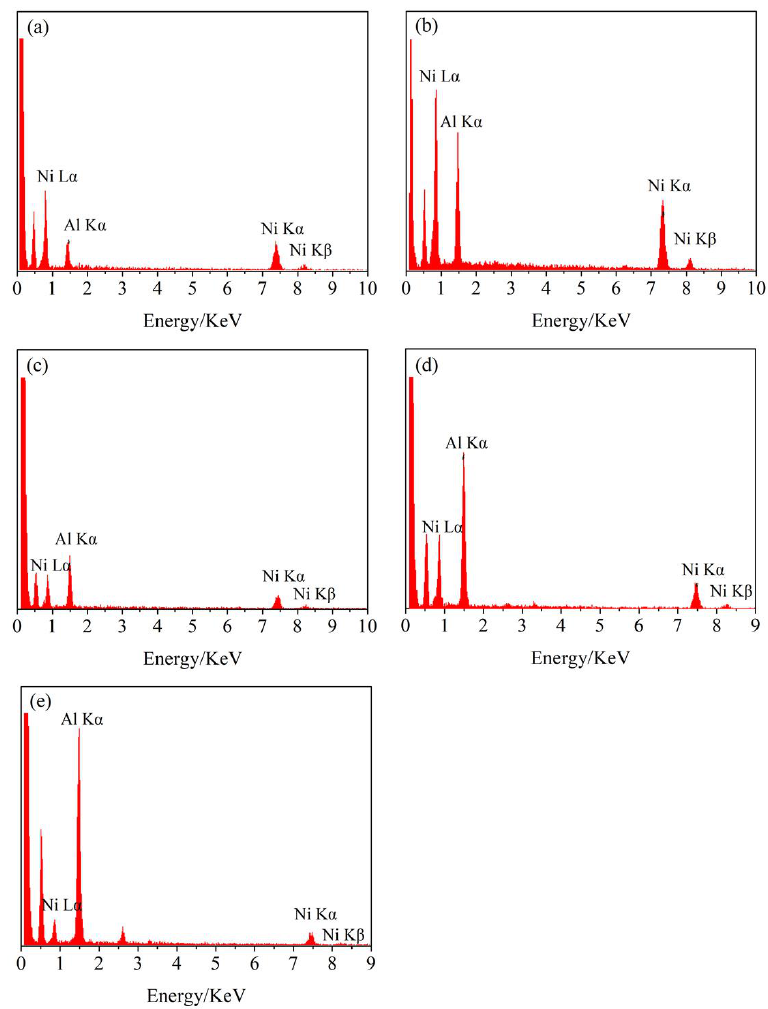
Figure 6. EDS of samples obtained by potentiostatic electrolysis on Ni plate at different potentials from LiCl-KCl-AlCl 3 (2 wt.%) melts at 753 K, ( a ) − 1.0 V (vs. Pt) for 9 h; ( b ) − 1.17 V (vs. Pt) for 12 h; ( c ) − 1.28 V (vs. Pt) for 12 h; ( d ) − 1.37 V (vs. Pt) for 12 h, and ( e ) − 1.47 V (vs. Pt) for 12